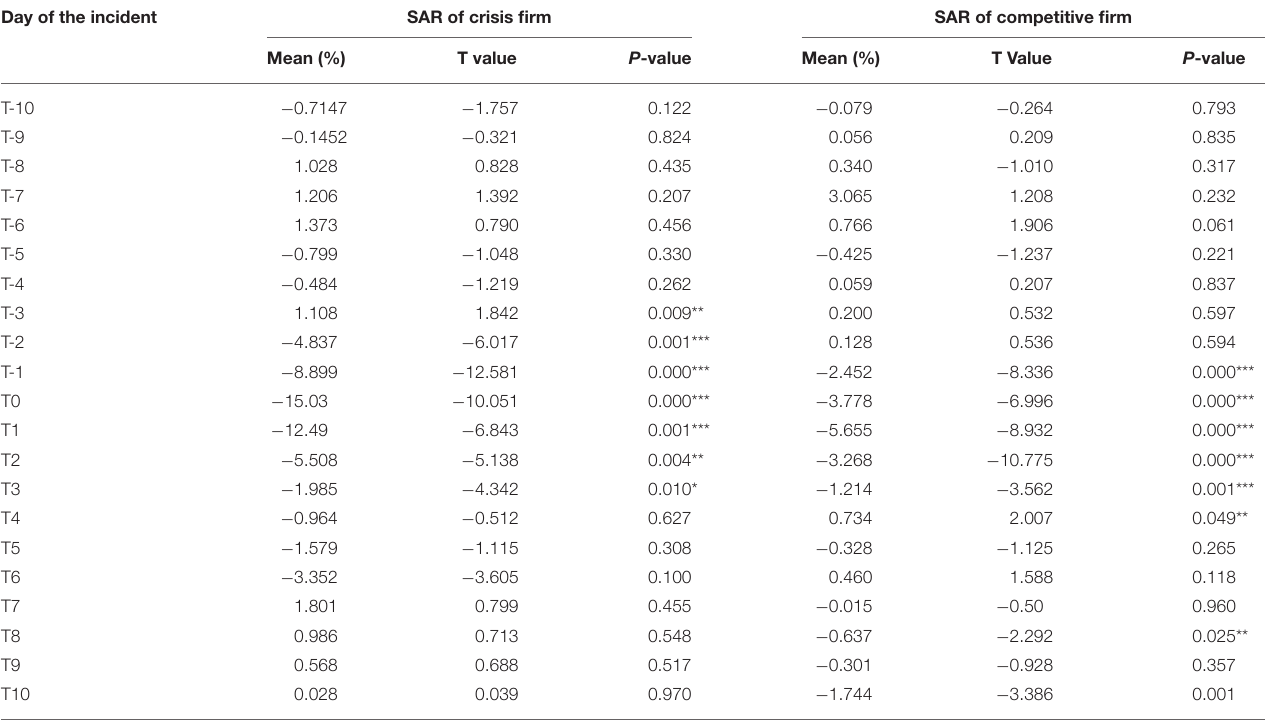
TABLE 3 | Summary of significance of statistics T AR of two types of sample firms during the incident period. Day of the